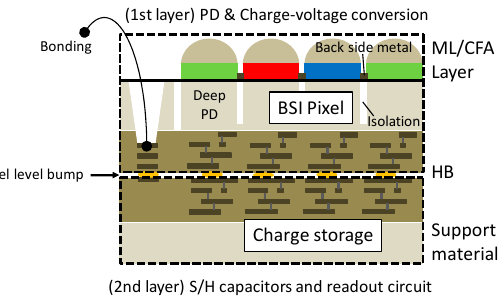
Figure 1. Cross sectional structure of the stacked backside-illuminated (BSI) pixel array. The micro lens (ML), color filter array (CFA) and deep photodiode (PD) are on the first layer. The sample and hold (S/H) capacitors and readout circuit are on the second layer and these two layers are connected by pixel level hybrid bump (HB).